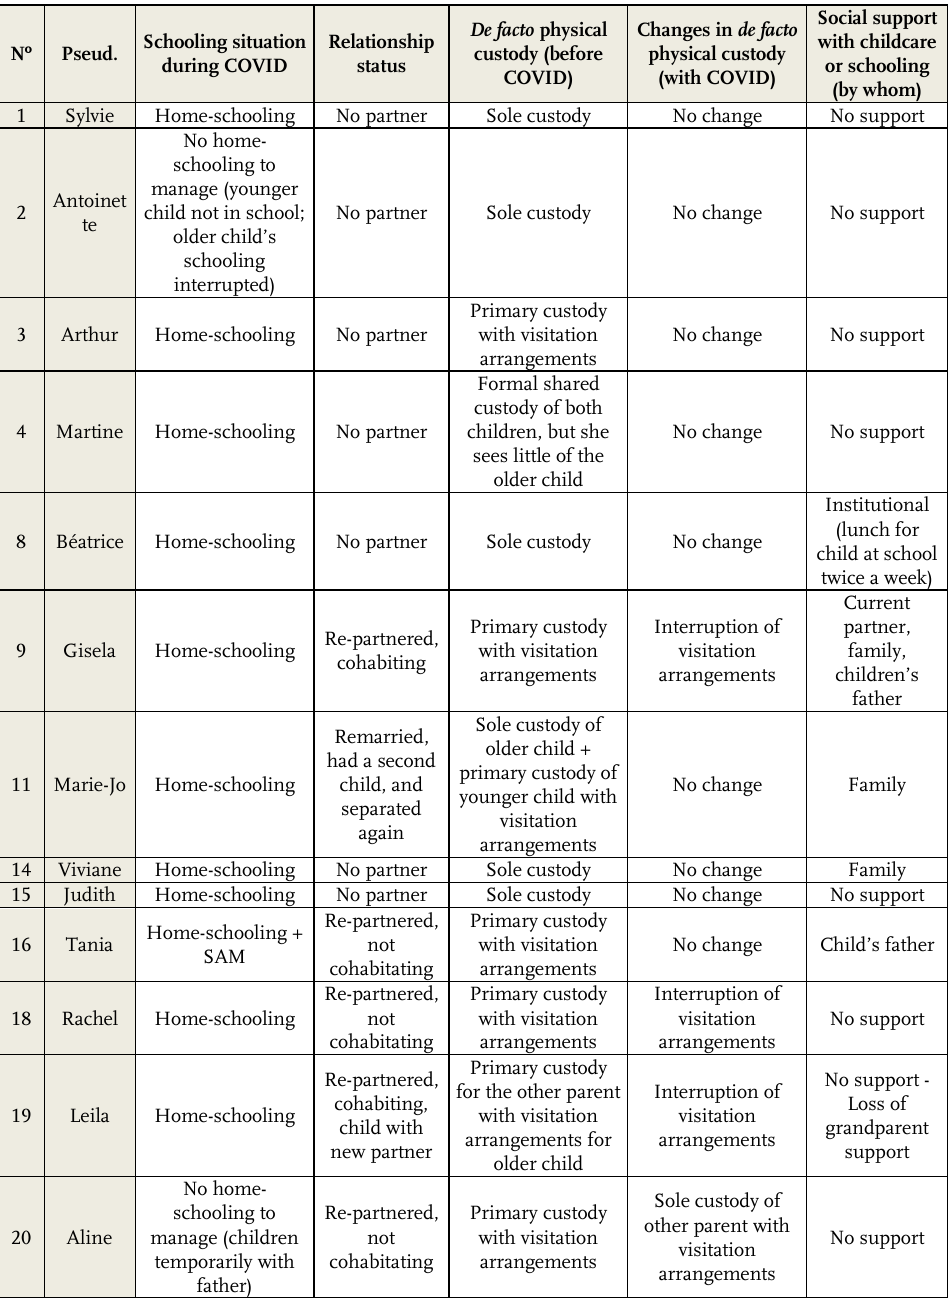
Table A.1 : Sample characteristics and changes in main life domains triggered by the pandemic